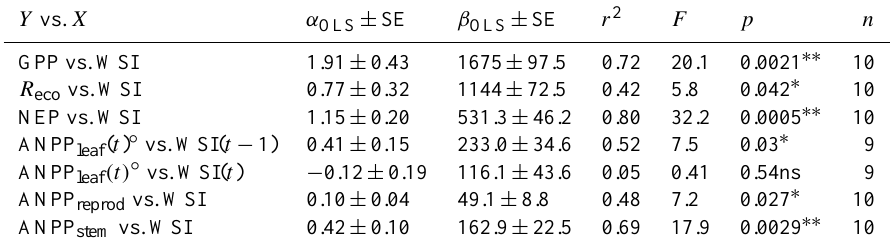
Table 1. Parameters of the linear ordinary least-square regression lines between the WSI in MPa day and components of the ecosystem yearly C budget and aboveground components of the productivity. α OLS is the slope of the Y vs. X relationship. GPP, R eco and NEP are gross primary productivity, ecosystem respiration and net ecosystem productivity, respectively, in gCm − 2 yr − 1 . The components of the aboveground productivity for leaves, reproductive effort and stem ANPP leaf , ANPP reprod and ANPP stem are also expressed in gCm − 2 yr − 1 . Y vs. X